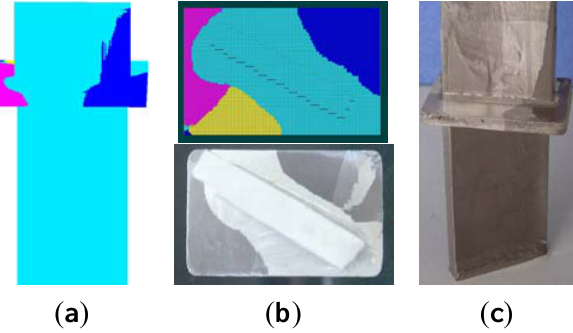
Figure 8. The comparison of microstructure of SG1with EG1 ( a ) The simualtion of microstructure of SX blade (partly); ( b ) The comparison between simulation and experiment (upward view, i.e. , the bottom surface of the platform); ( c )The experimental result of